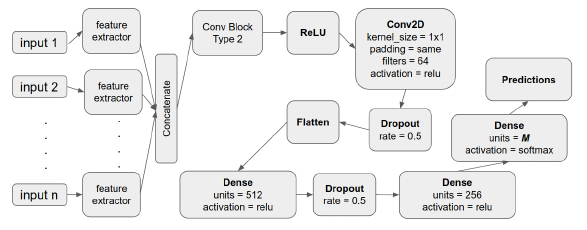
Figure 1. Architecture of the MM model. M and n denote the number of classes and input raster types, respectively. The feature extractor module is illustrated in Figure 2. Conv Block Type 2 is shown in Figure 3 Figure 4. Architecture of the MM-HR model. M and n denote the number of classes and input raster types, respectively. The feature extractor module is illustrated in Figure 5. Convolutional Block and Residual Block are shown in Figures 6 and 7